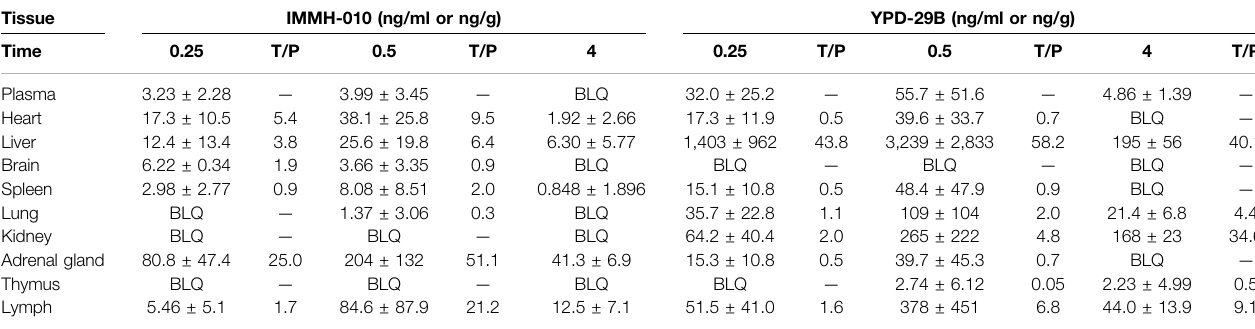
TABLE 8 | Tissue distribution of IMMH-010 and YPD-29B after i.g. administration of IMMH-010 maleate at 10 mg/kg ( n (cid:1) 5). Tissue